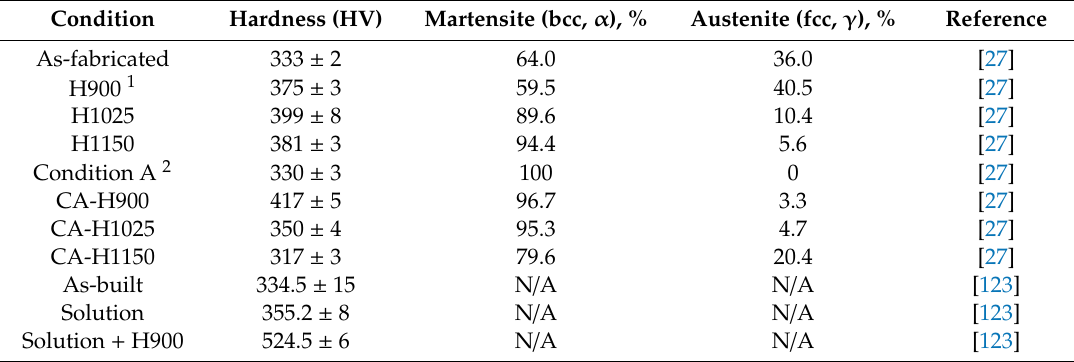
Figure 12. ( a ) Three-dimensional macro-morphology of L-PBF specimen; ( b , c ) microstructure of L-PBF specimen; ( d , e ) microstructure of L-PBF-quenched specimen; ( f , g ) microstructure of conventionally melted (CM) specimen. (Material: 17–4 steel) Arrows indicate ferrite-rich area [17]. Table 6. The e ff ect of heat treatment conditions on hardness (material: 17–4 steel). Condition Hardness (HV) Martensite (bcc, α ), % Austenite (fcc, γ ), %